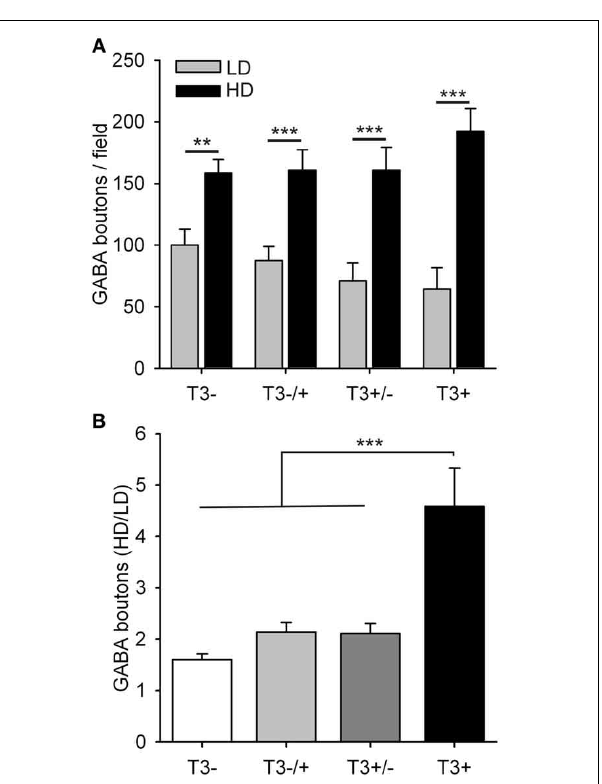
FIGURE 7 | Quantification of L-GABA axon parameters in T3 − and T3 + cultures at 21DIV. (A,B) Bouton density data were grouped into fields, with low ( ≤ 3 non-GABA/field) or high ( > 3 non-GABA/field) cell densities. (A) . In all culture conditions the number of GABAergic boutons was increased in fields with high neuronal density compared with fields of low neuronal density. (B) . The ratios of bouton numbers (high/low density fields, HD/LD) did not recover when neurons were treated with T3, after a T3 deficit during the first 2 weeks in vitro (T3 − / + ). After the 6-day treatment with K252a ( Figures 8C,E,G,J